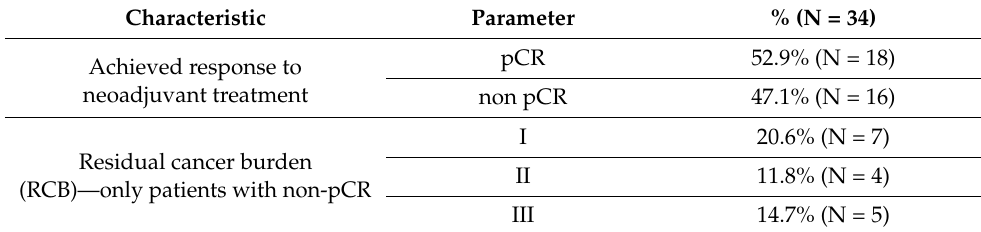
Table 3. Characteristics of achieved responses to